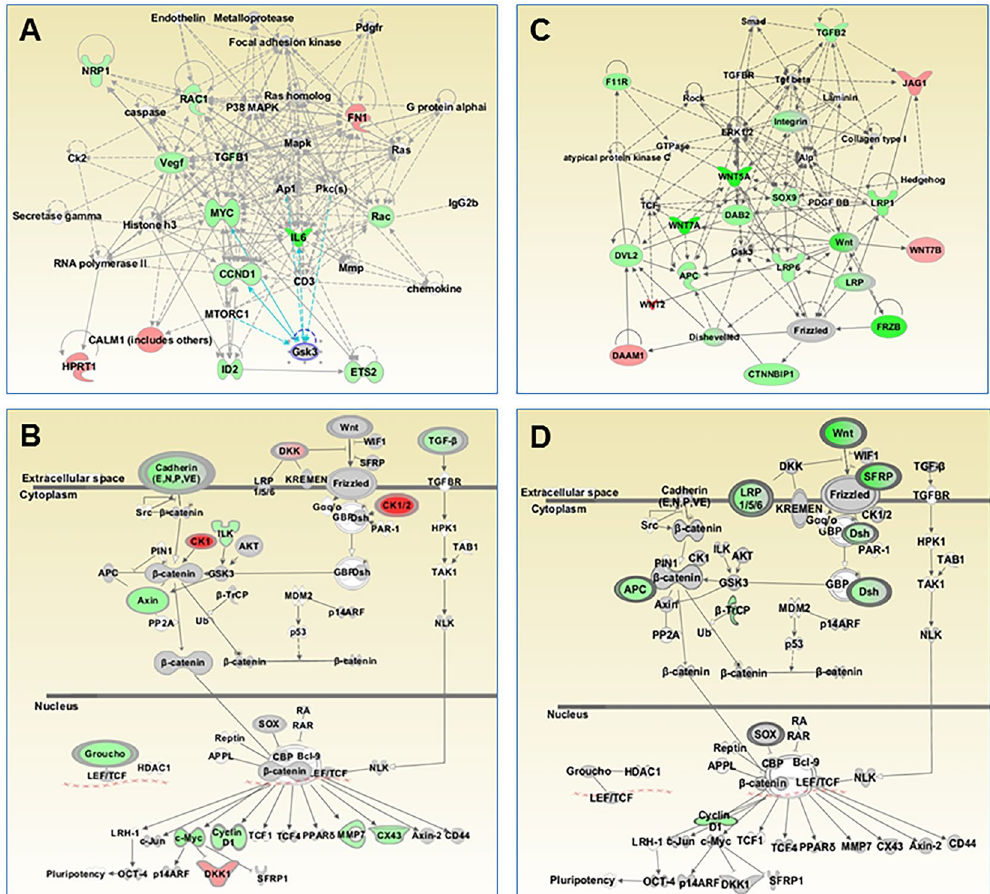
Figure 6. Modulation of Wnt/FZD4 signaling pathways through the interaction of miR-204 with FZD4- miR-SNP (rs713065) variant in NSCLC cells. (A) The top-scored network in Cell Cycle, Gene Expression, and Cellular Function and ( B ) canonical Wnt/ β -Catenin signaling pathway associated with FZD4-miR-SNP (rs713065) and Wnt5A activities in H1299 cells were representatively displayed. H1299 cells were transfected with either FZD4-SNP-3 ′ UTR or FZD4-WT-3 ′ UTR. After incubation for 48 h, the total RNAs were isolated and absolute gene expression profiles were determined by nCounter, with differentially expressed pathways identified through Ingenuity ® Pathway Analysis. (C) Modulation of top-scored cellular network and ( D ) Wnt/ β -Catenin canonical pathways through the miR-204 targeted FZD4 expression in 3 ′ UTR containing FZD4-miR-SNP. Key molecules identified through NanoString and IPA analysis (red if is up-regulated in H1299 cells co-transfected with FZD4-SNP/Wnt-5a compared to FZD4-WT/Wnt-5a in the presence or absence of the ectopic expression of miR-204, green if is down-regulated). The intensity of the color indicates expression level or degree of regulation. The top-scored networks and signaling pathways and their associated molecules and cellular functions were summarized in details in Supplementary Tables 1–5)